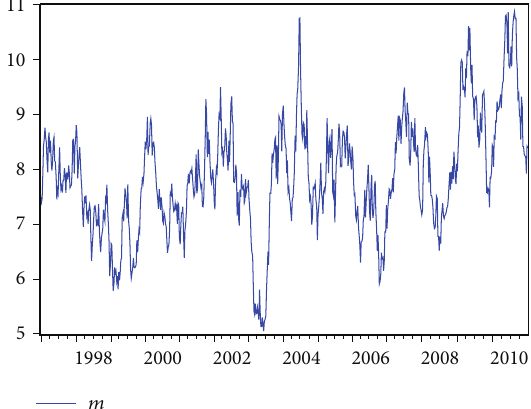
Figure 6: Determination of dynamic CPPI